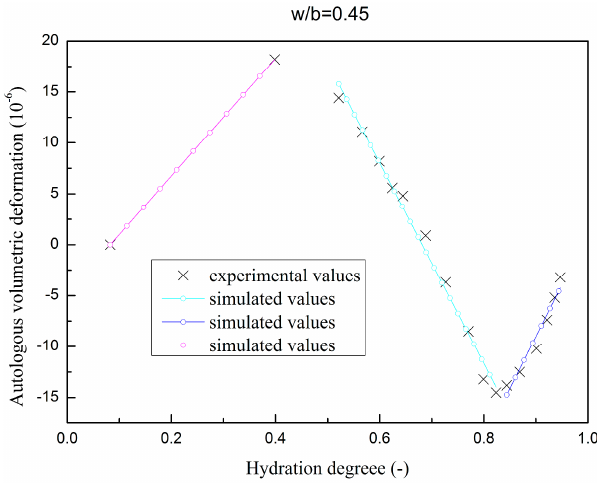
Figure 4. Young’s modulus and Poisson’s ratio evolution for isothermal test of fly ash concrete (w/b = 0.48). Materials 2016 , 9 , 378